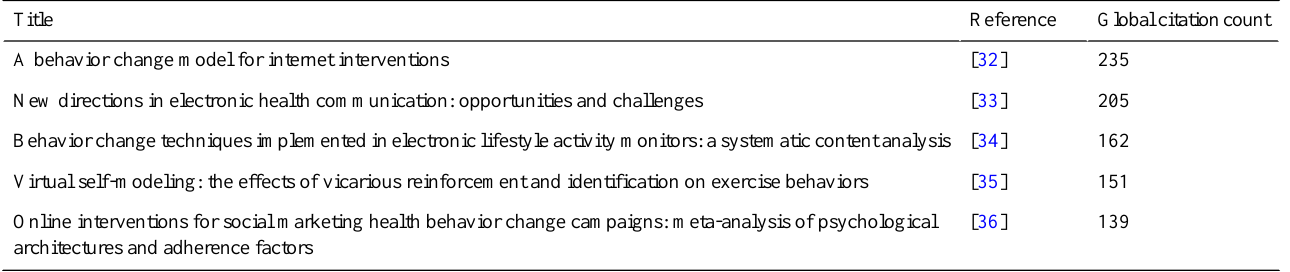
Table 3. Top 5 of the globally most citied